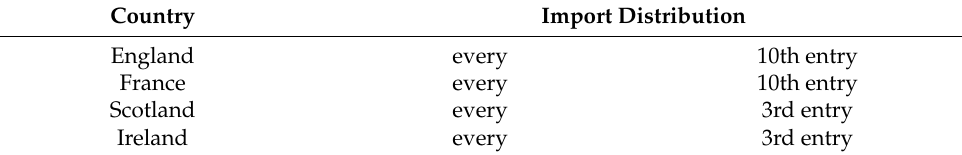
Table 2. Imported data